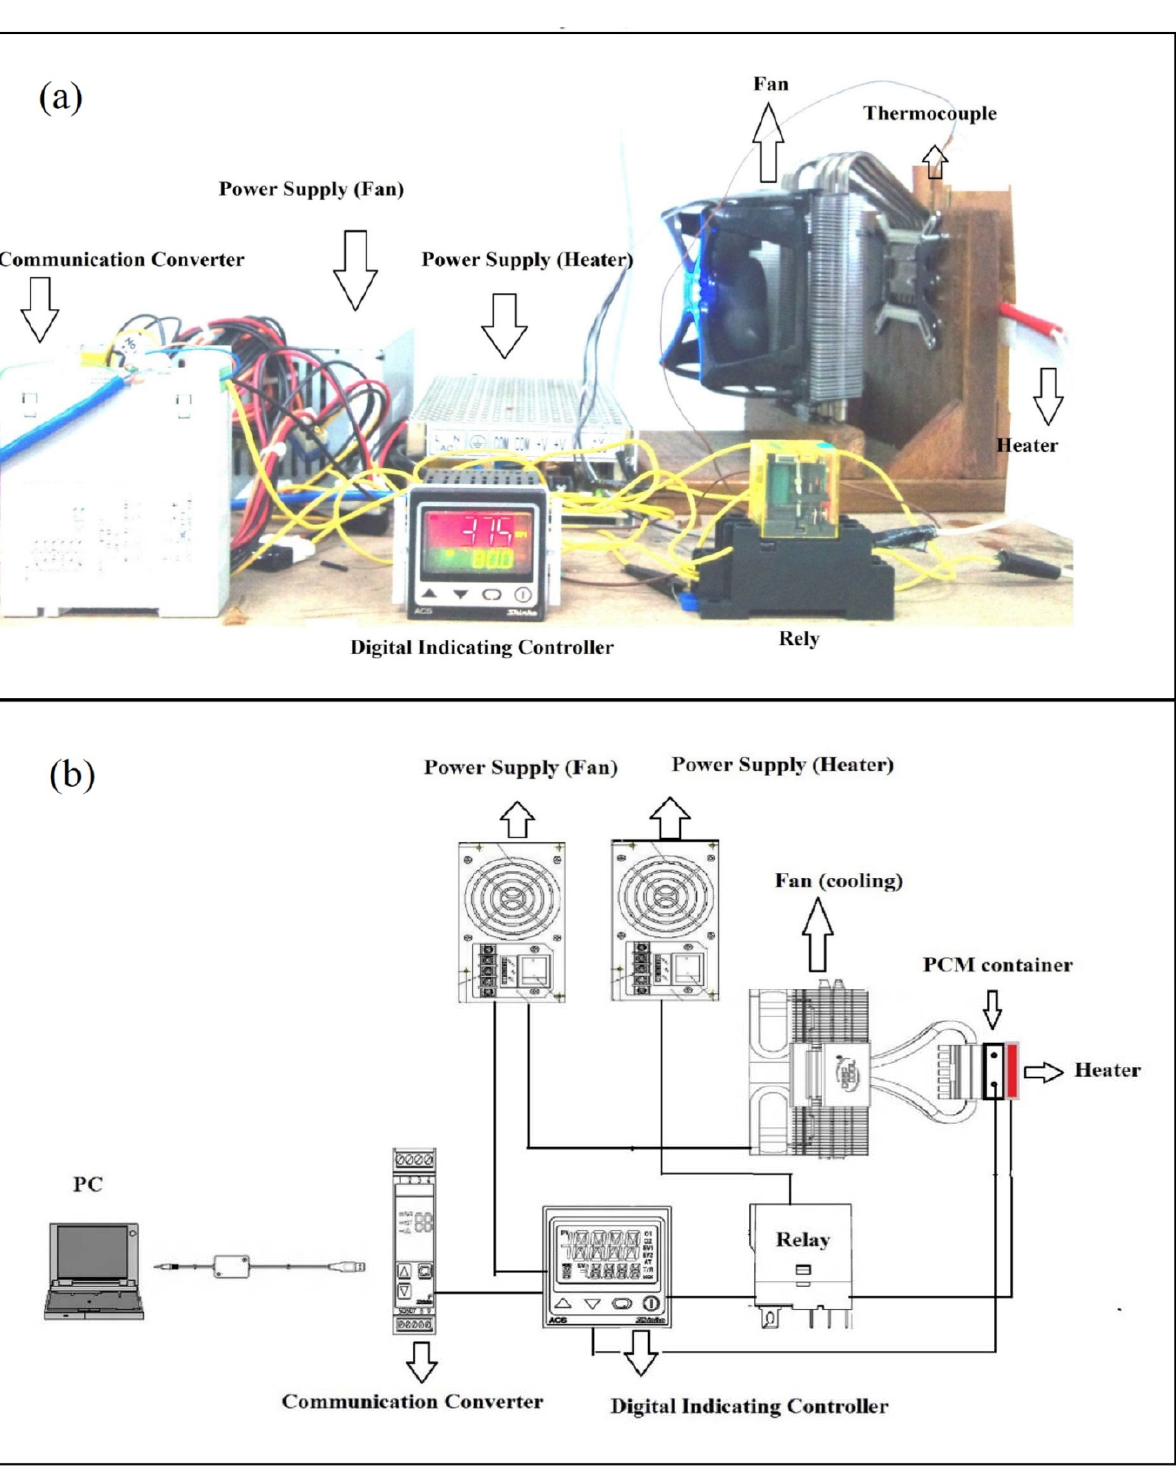
Figure 1. ( a ) Image of repeated thermal cycling test; ( b ) schematic of repeated thermal cycling test